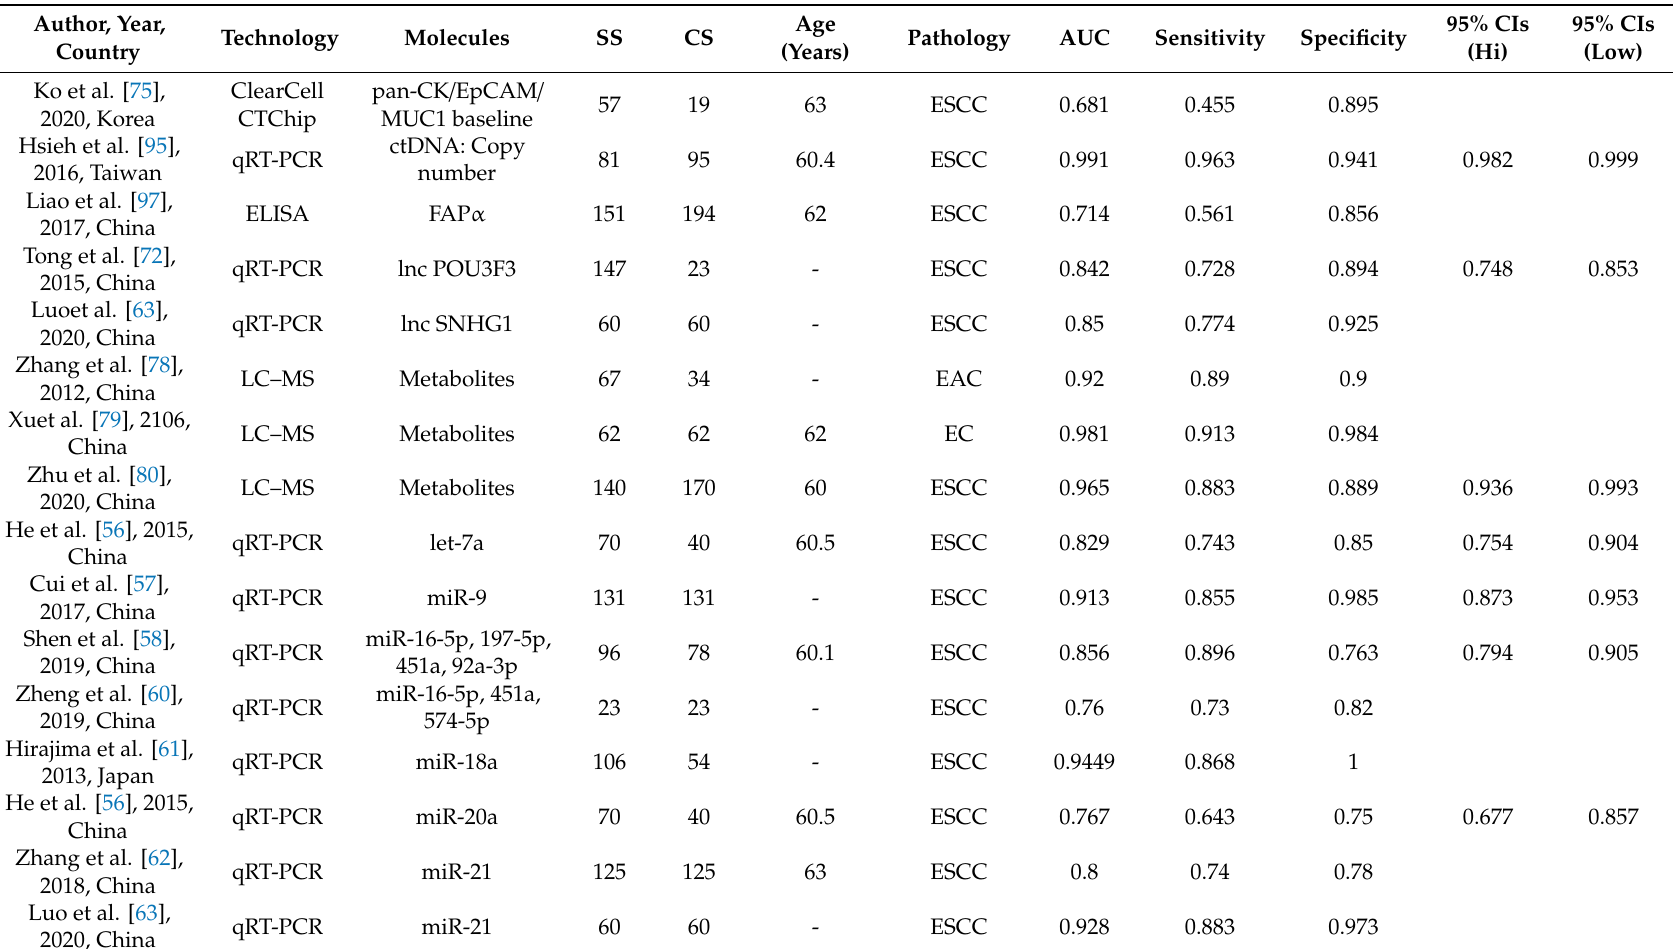
Table 3. The results of the liquid biopsies for diagnostic